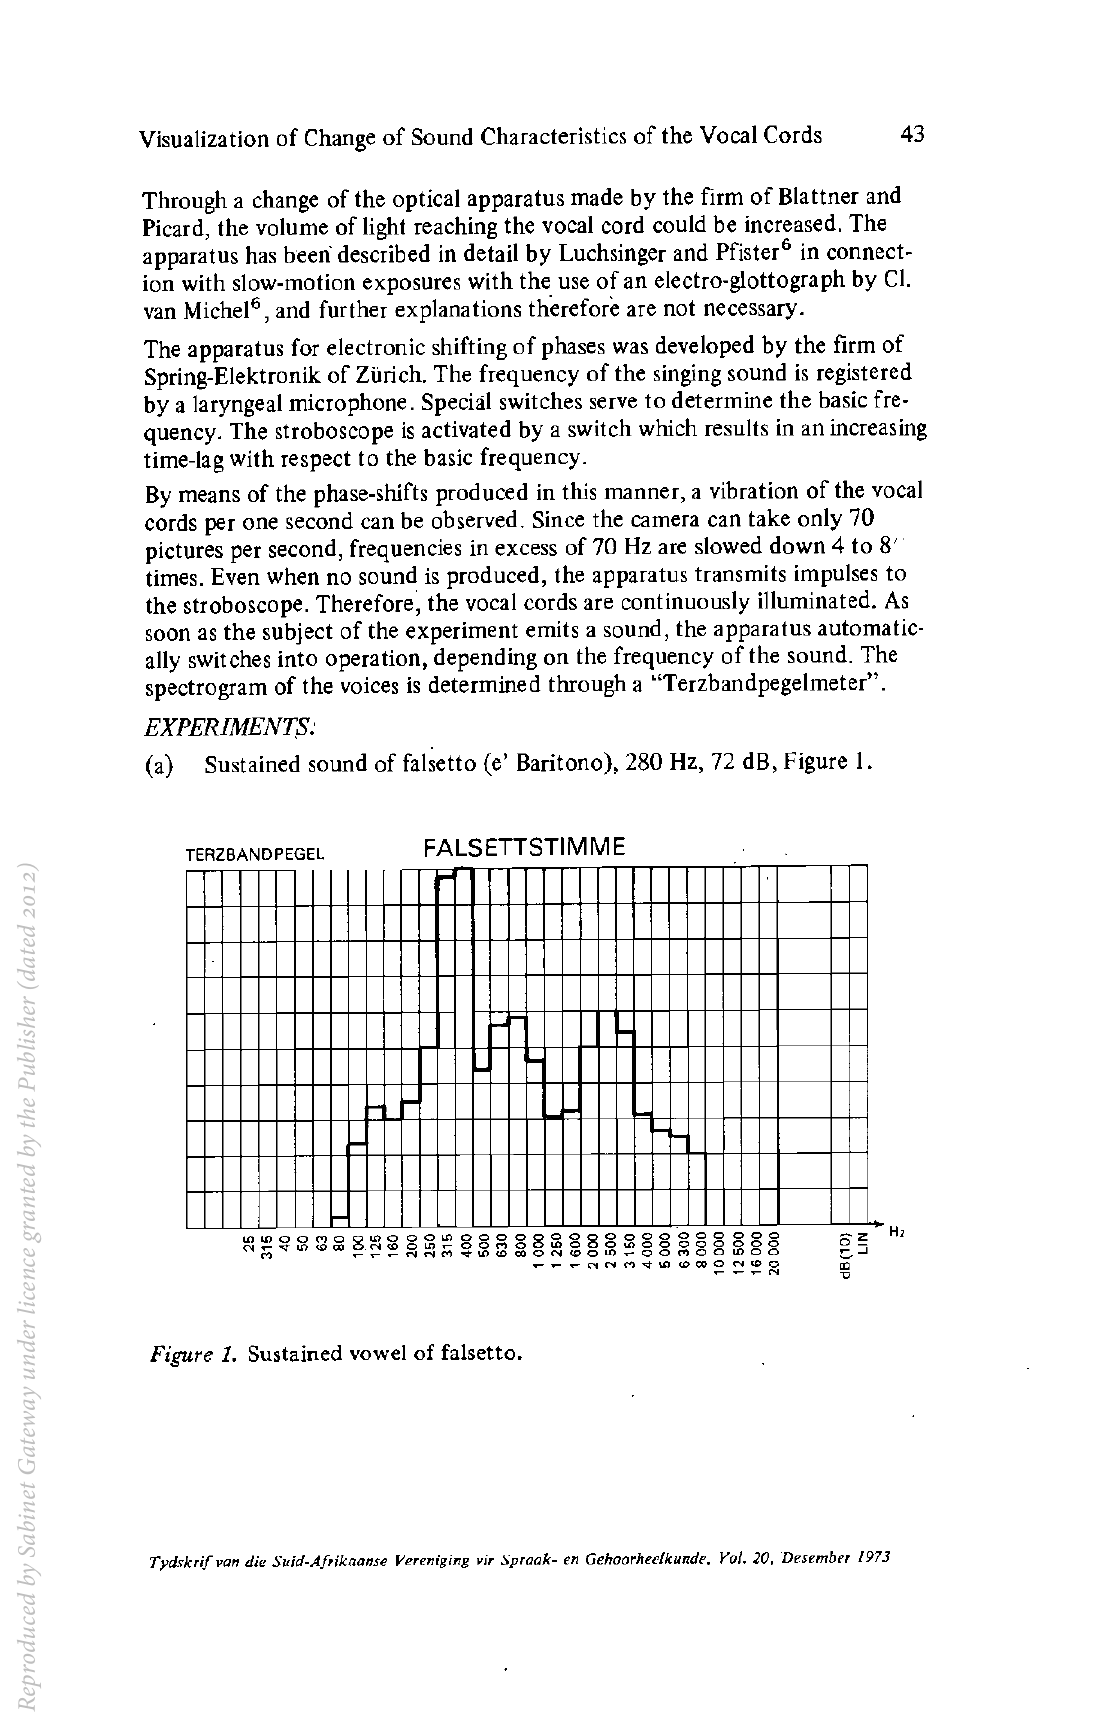
Tydskrif tan die Suid-Afrikaanse Vereniging vir Spraak- en Cehoorheelkunde, Vol. 20, Desember